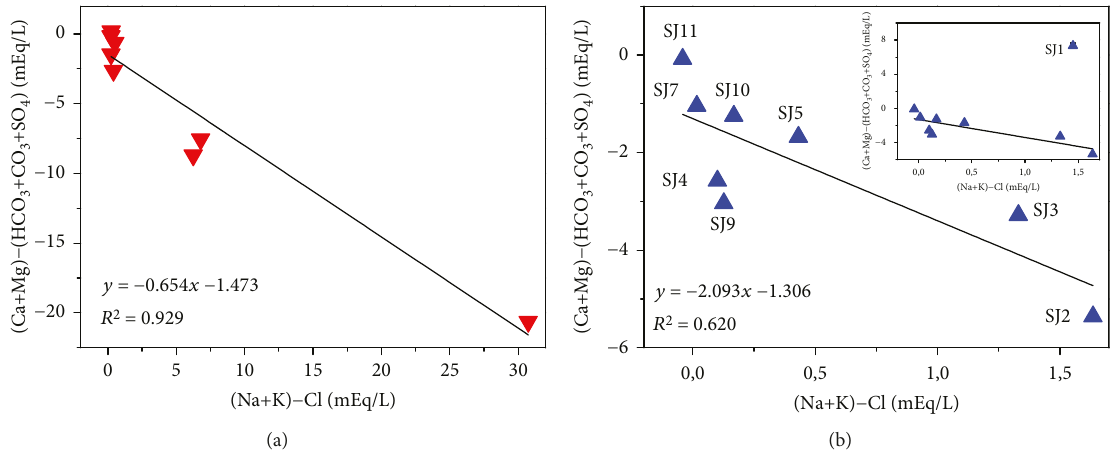
− + CO 2 − + SO 2 − on mEq/L: (a) Coconuco sector and (b) San 3 3 4